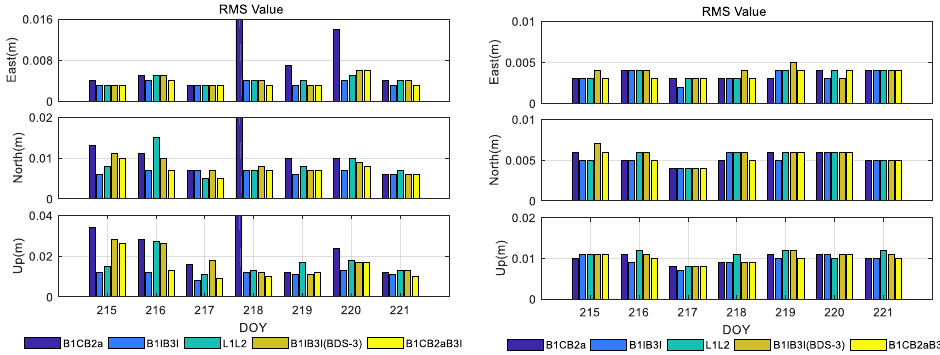
Figure 4. METG–MET3 (3 km) instantaneous short baseline RTK positioning accuracy. The left sub- plot shows the instantaneous ambiguity fixing strategy, and the right subplot shows the continuous ambiguity fixing strategy. Table 5. METG – MET3 (3 km) average of instantaneous short baseline RTK RMS and ambiguity fixing rate . The upper part of the table is the instantaneous ambiguity fixing strategy, and the bottom part of the table is the continuous ambiguity fixing strategy.